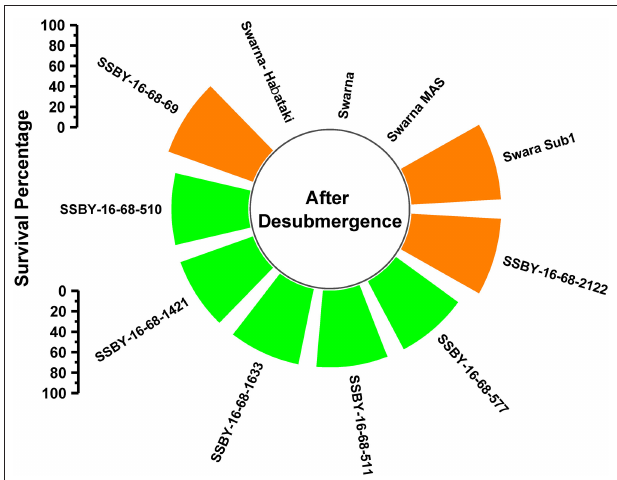
FIGURE 5 | Percentage of plant regenerated under control submergence screening for the Sub1 QTL carrying lines and its parents after 14 d of submergence stress and 7 days of desubmergence.